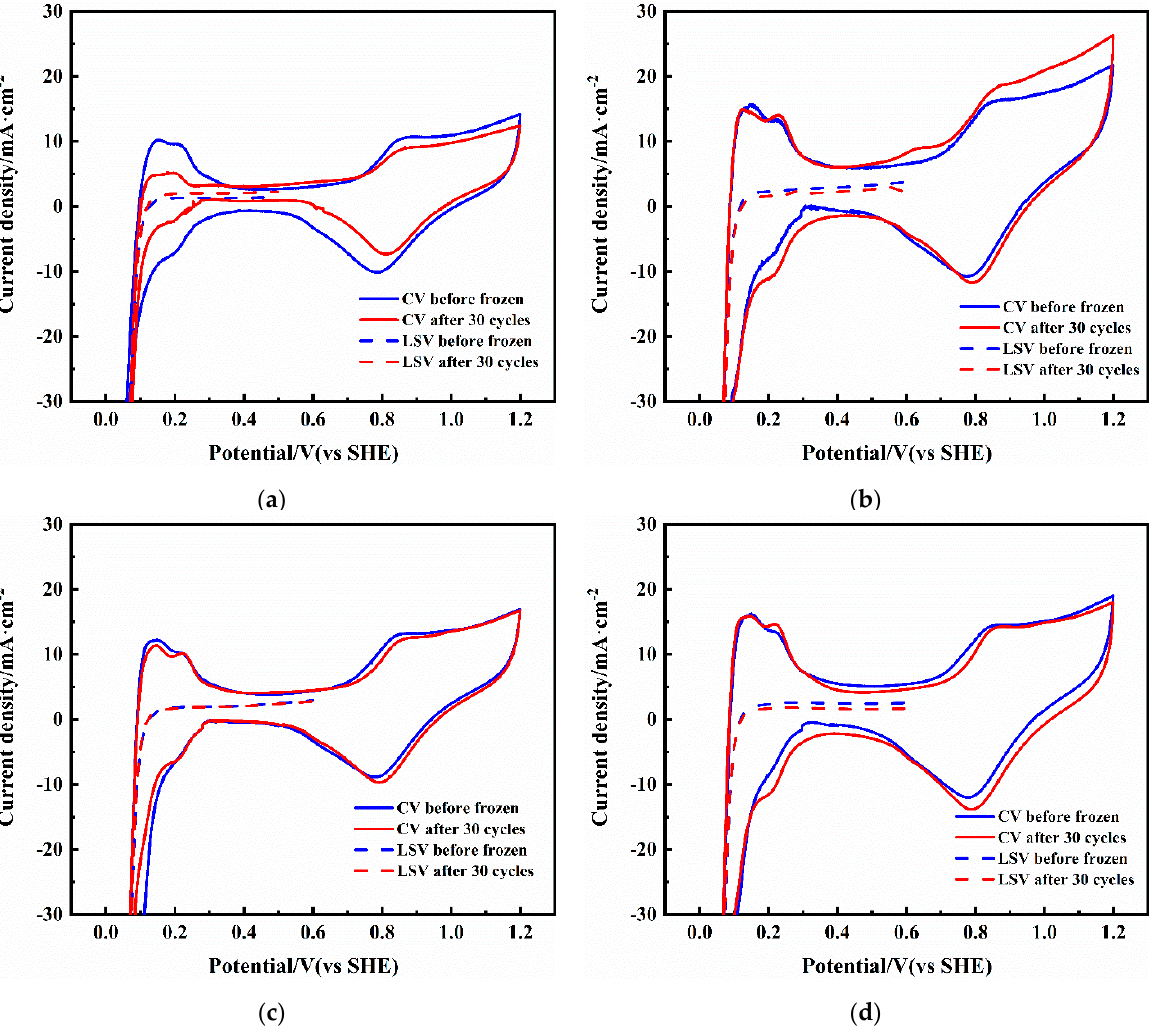
Figure 5. CV and LSV of single cells before and after 30 freeze/thaw cycles with different initial membrane water content: ( a ) Cell-1 with λ = 14; ( b ) Cell-2 with λ = 12.0; ( c ) Cell-3 with λ = 10.0; ( d ) Cell-4 with λ = 8.2. Table 3. The ECSA before and after freeze/thaw cycles.